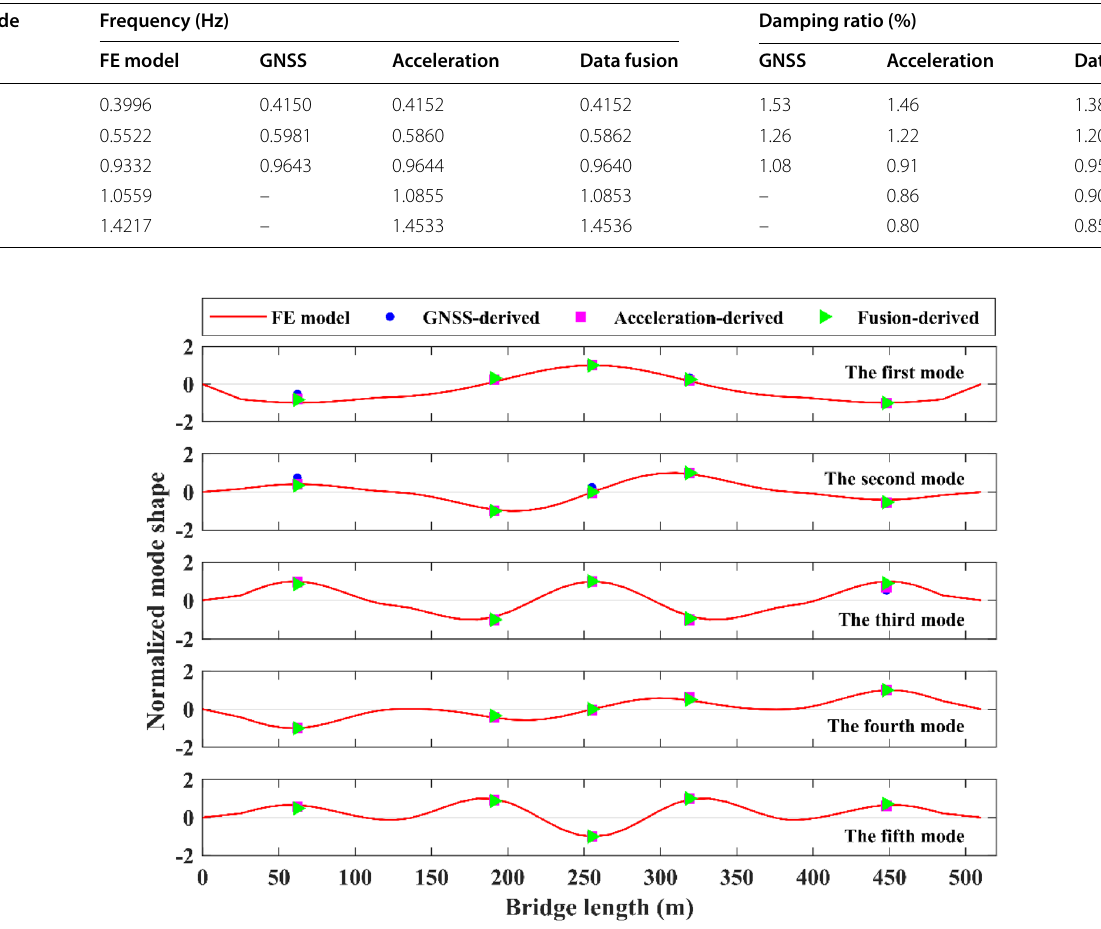
Fig. 13 Identified first five vertical mode